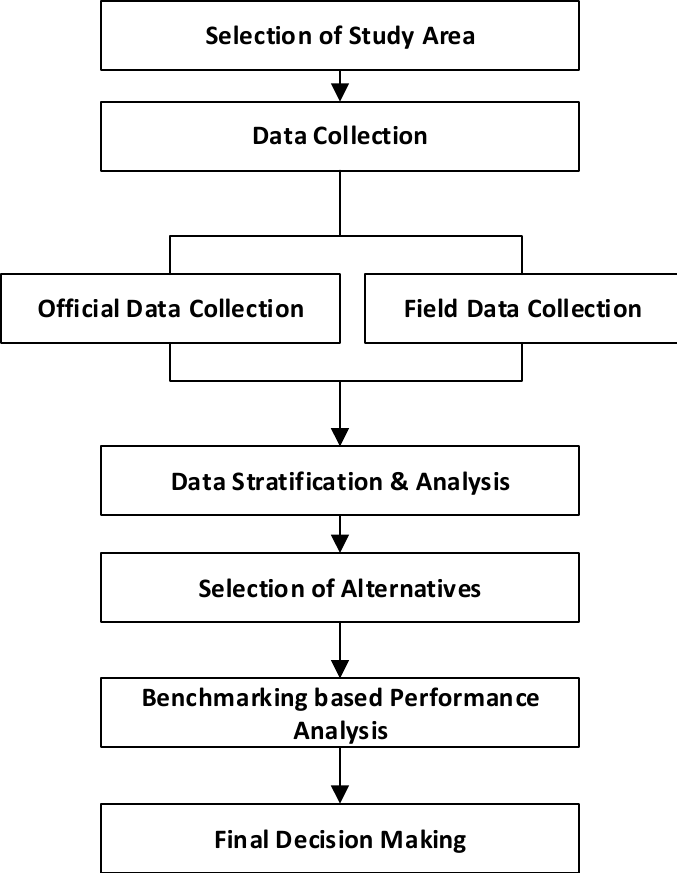
Figure 2. Research Methodology.